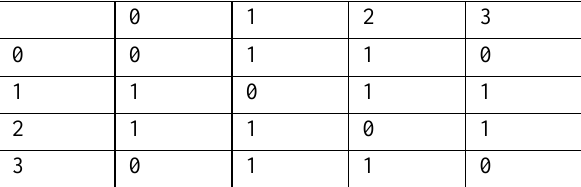
Table 1: Adjacent matrix of graph of figure 1 The entries in the matrix stored in table 1 consist of binary values. The value 0 in any cell represents that the vertex in the corresponding row is non-adjacent vertex of the corresponding column (like node 0 is non-adjacent node to 3) otherwise vertex in the row is the adjacent vertex of corresponding column vertex (like node 1 is the adjacent node to vertex 3). The adjacency matrix generated for the graph is stored in a two-dimensional array of size NxN where N is the number of vertices in the graph. We used additionally colour matrix that stores feasible colour information corresponding to each vertex in the graph. The colour matrix created for the graph in figure 1 is shown in table 2.